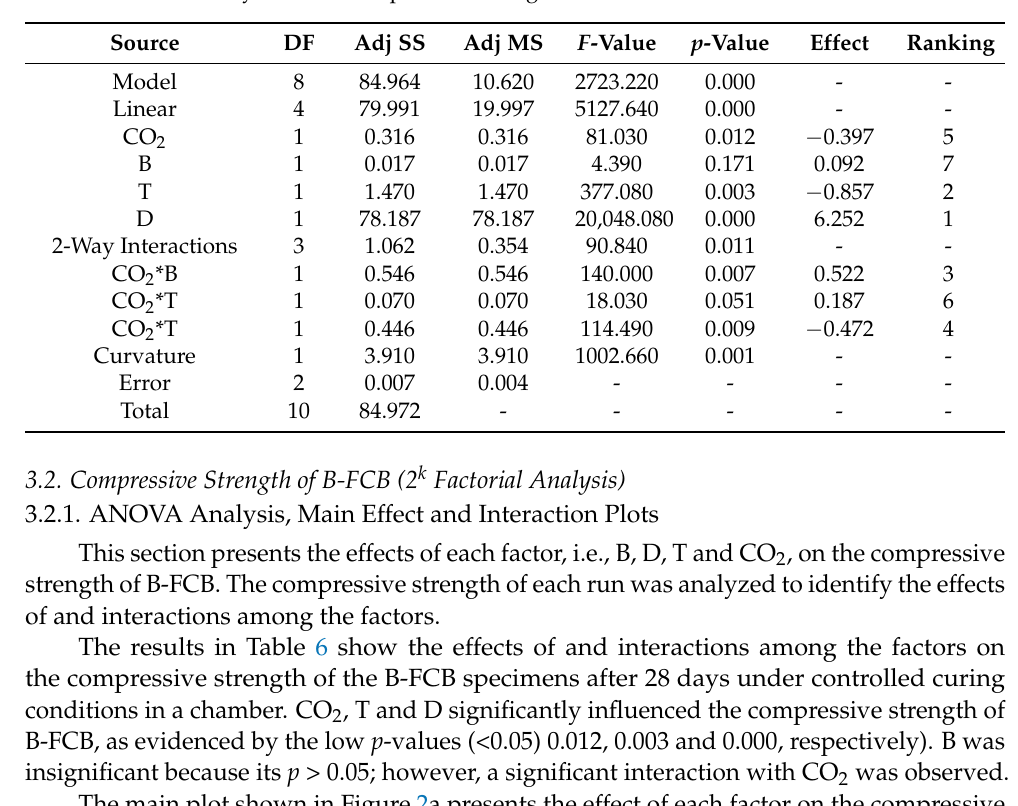
Table 6. ANOVA analysis of the compressive strength of